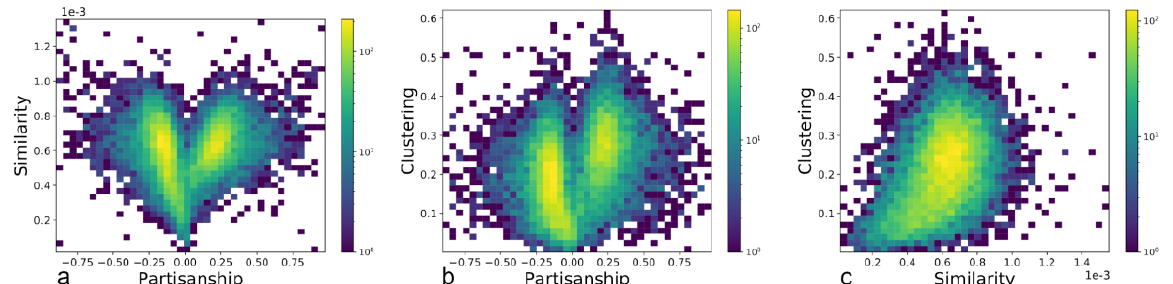
Figure 3. Relationship between independent variables. Color indicates the number of users. (a) Partisanship and similarity: Pearson correlation r = 0.45 for left-leaning users and r = 0.42 for right-leaning users. (b) Partisanship and clustering: r = 0.21 for left-leaning users and r = 0.19 for right-leaning users. (c) Similarity and clustering: r = 0.40. All correlations are significant (p < 0.01).